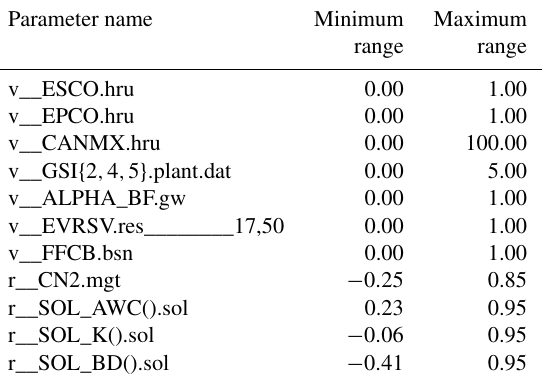
Table B1. The 11 parameters and their minimum and maximum range used in this study for the first iteration (1000 simulations) of all six